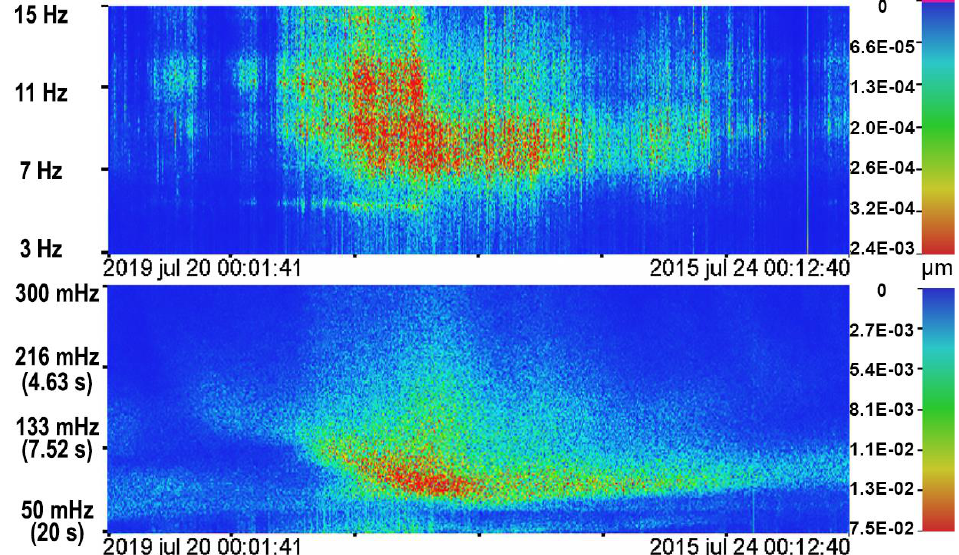
Figure 12. Dynamic spectrograms of laser strainmeter data during influence of Danas typhoon.